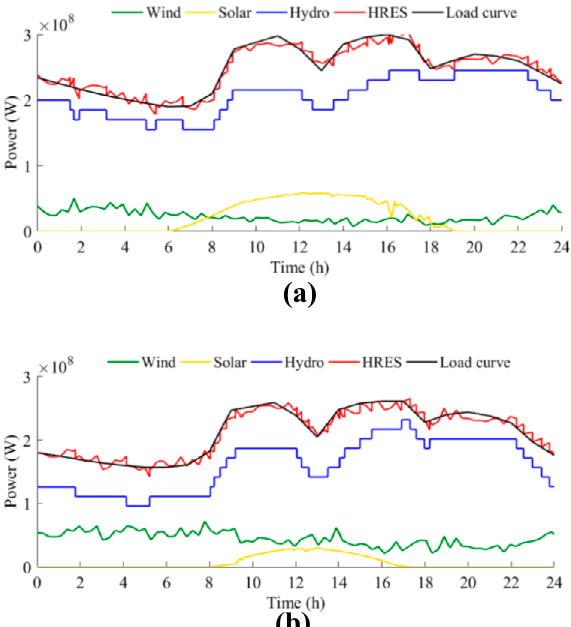
Figure 10. The ultra-short-term adaptive deduction results: ( a ) typical summer day and ( b ) typical